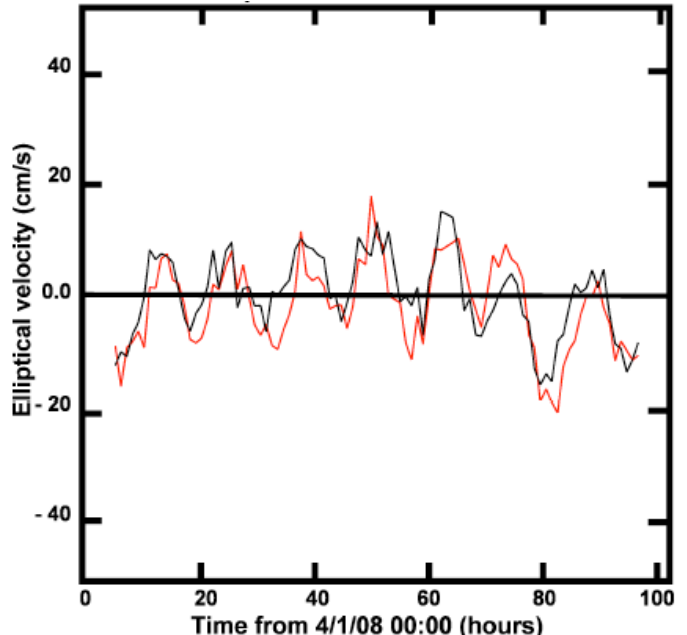
Figure 19. Time series of elliptical velocities measured at the point shown in Figure 18. Black—calculated from total velocity vectors produced by COMM, FORT. Red—measured by COMM.